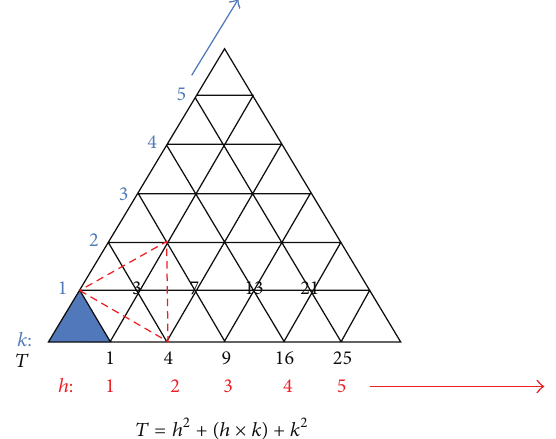
Figure 5: A family of icosahedra. Shown at the bottom of the large triangle, in blue, are the members of the 𝑃 = 1 icosa- hedra. The triangulation number represents the number of non- or quasiequivalent structural morphological units per asymmetric unit of the icosahedral face. 𝑇 = 1 is the only structure with a single equivalent morphological unit per icosahedral face, shown in blue. Neighboring 5-fold vertices of the 3-fold triangular face are connected to one another by three 2-fold axes giving the structure an overall 5-fold, 3-fold, and 2-fold symmetry. The 𝑇 number, also determined by the formula 𝑇 = ℎ 2 + (ℎ × 𝑘) + 𝑘 2 , indicates the relative position of each 5 fold vertex as a function of the number of quasiequivalent morphological units per icosahedral face. Sindbis, with four quasiequivalent conformations of the E1E2 heterodimer, is a 𝑇 = 4 structure. In the capsid mutant Y180S/E183G, the flexibility of the capsid protein is altered allowing the mutant protein to adopt a wider range of quasiequivalent conformations that increases the triangular number of the structure. Superimposed on the 𝑃 = 1 lattice is a class 3 triangular face outlined in red. Flaviviruses are arranged in this 𝑇 = 3 symmetry and belong to the class 𝑃 = 3 icosahedra shown in black on the 𝑘 = 1